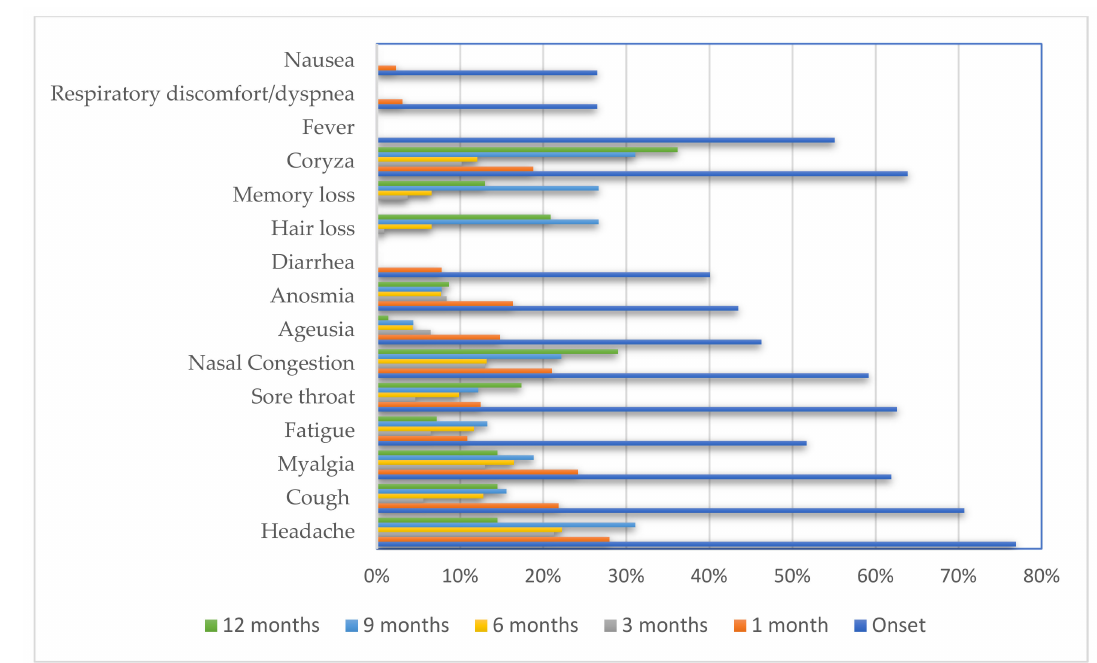
Figure 2. Persistence of self-reported symptoms of COVID-19 according to the time since onset of COVID-19. COVID-19; coronavirus disease